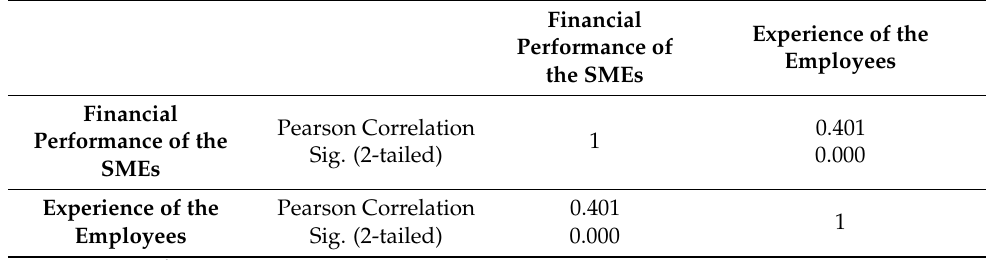
Table 19. Correlation of Experience of the Employees with Financial Performance of the SMEs.